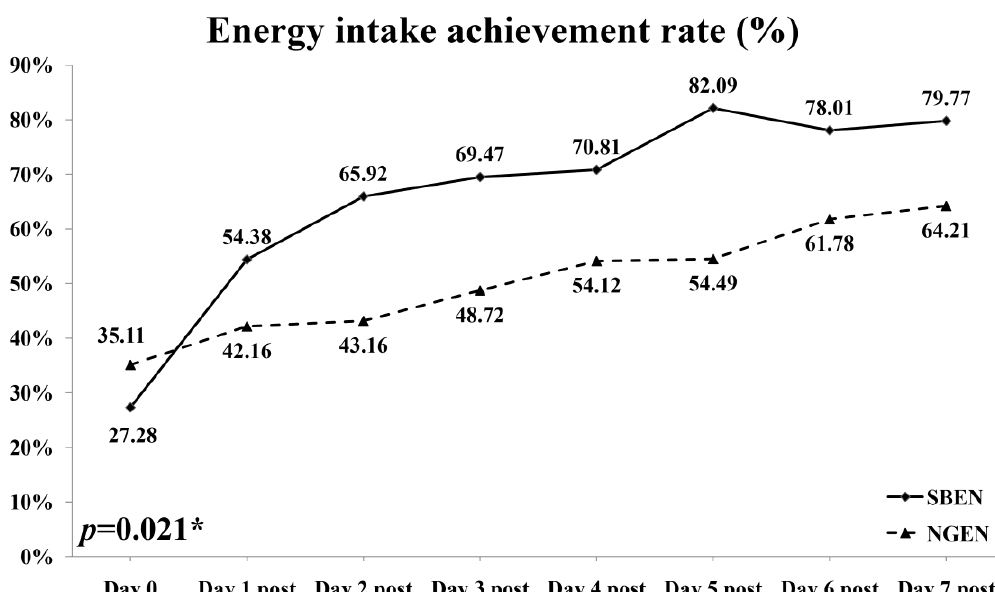
Figure 1. Achievement rate of energy intake for SBEN and NGEN groups. p = 0.021